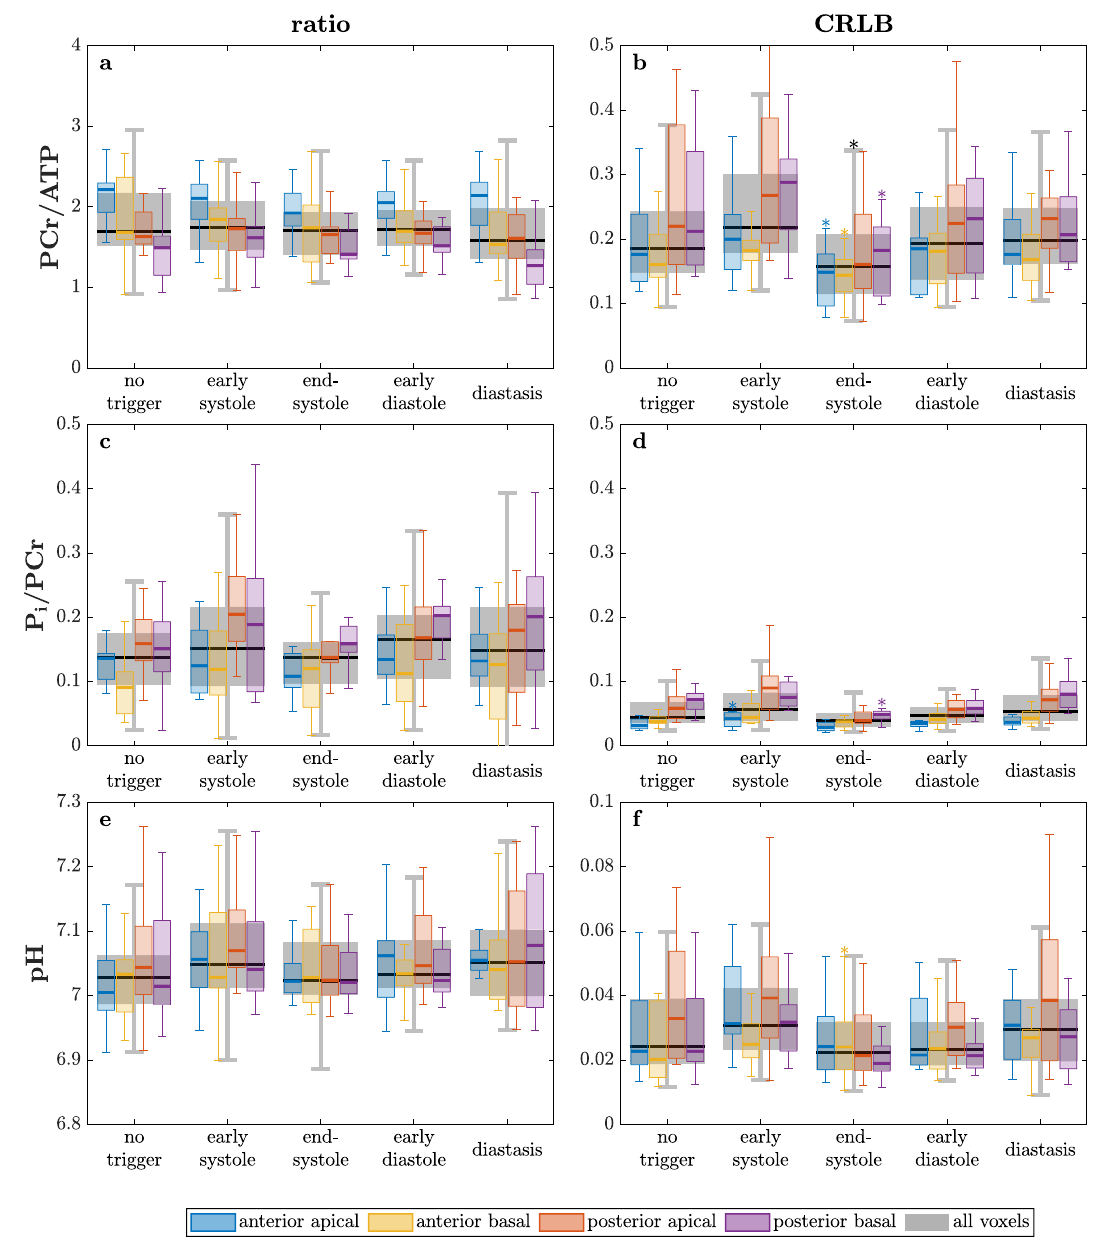
Figure 3. Metabolite ratios PCr/ATP ( a ), P i /PCr ( c ), pH ( e ) values and their respective CRLBs ( b , d , f ) over the cardiac cycle for all subjects. Boxplots depict median (line), IQR (box) and 1.5 × IQR (whiskers) of the study cohort; outliers not shown. * P < 0.05 to